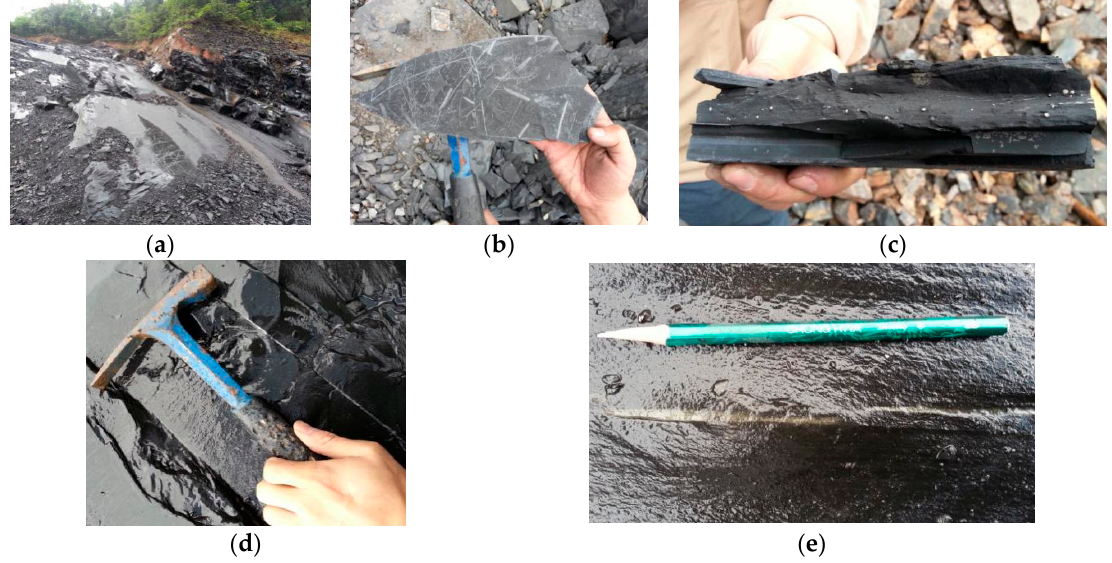
Figure 2. Longmaxi Formation shale outcrops and various mineralogic components: ( a ) Shale outcrops; ( b ) Graptolite and radiolarian fossil; ( c ) Oolitic pyrite; ( d ) Interbedding developed quartz veins; and ( e ) Interbedding developed pyritic veins.